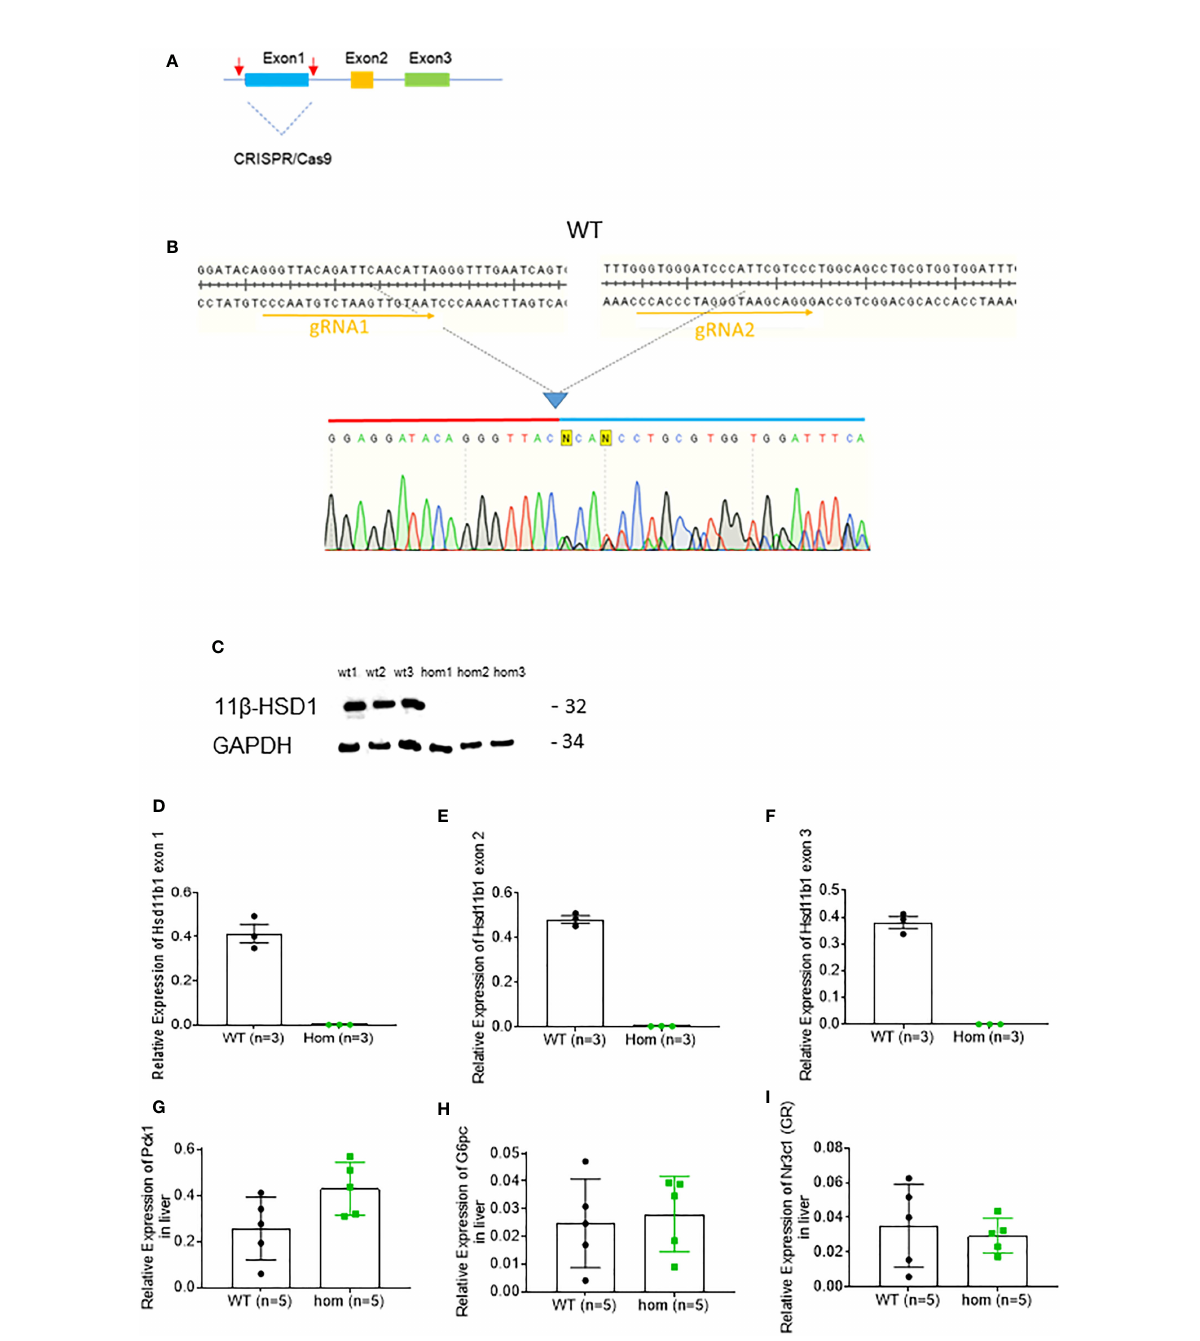
FIGURE 4 Generation and characterisation of Hsd11b1 -/- mice. (A) Diagram of gene deletion via CRISPR/Cas9 genome editing technology. Two gRNAs fl anking exon1 of Hsd11b1 gene were designed to delete entire exon1. (B) Con fi rmation of CRISPR/Cas9 mediated genomic DNA deletion by Sanger sequencing. (C) Western Blot analysis of kidney cortex lysate from Hsd11b1 -/- (hom), and Wild-type (WT) mice for 11 b -HSD1 -/- (32kDa) and GAPDH (34kDa). (D) Quantitative PCR levels of Hsd11b1 exon 1 gene expression in the liver of Hsd11b1 -/- (hom) and WT mice. (E) Quantitative PCR levels of Hsd11b1 exon 2 gene expression in the liver of Hsd11b1 -/- (hom) and WT mice. (F) Quantitative PCR levels of Hsd11b1 exon 3 gene expression in the liver of Hsd11b1 -/- (hom) and WT mice. (G) Quantitative PCR levels of Pck1 gene expression in liver. (H) Quantitative PCR levels of G6pc gene expression in liver. (I) Quantitative PCR levels of Nr3c1 (GR) gene expression in liver. Data are expressed as means ±